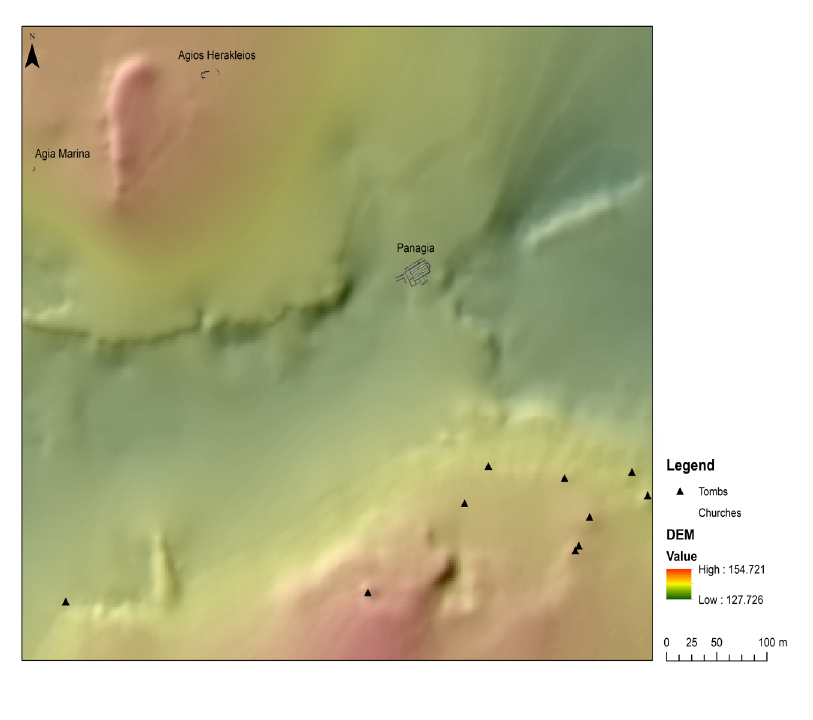
Figure 14: Micro-topographical map of the Geometric–Medieval site of Panagia Kofinou, showing the location of churches and rock-cut tombs (map by Niki